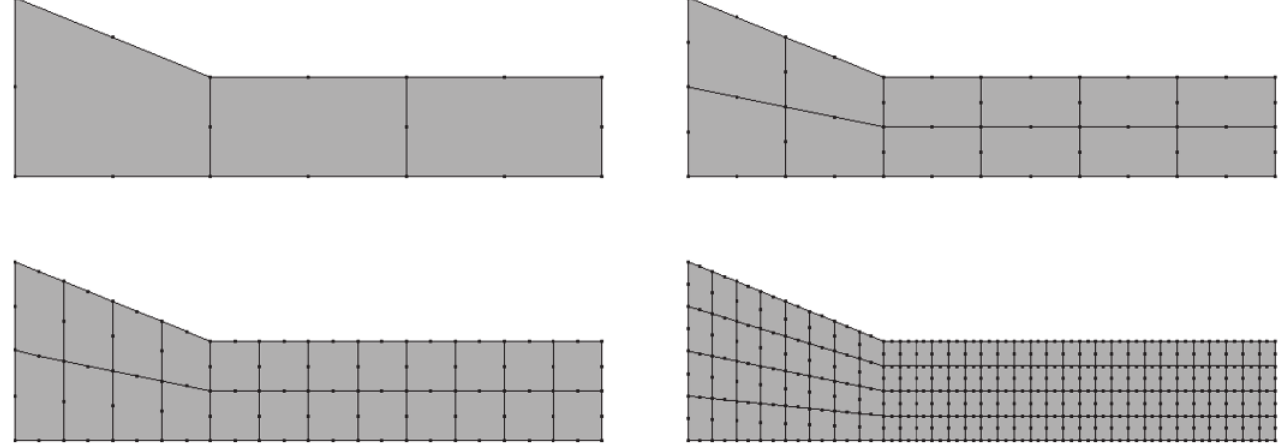
Dogbone-shaped panel – FEM meshes with: (a) 03, (b) 12, (c) 24 and (d) 128 quadrilateral eight-nodes elements